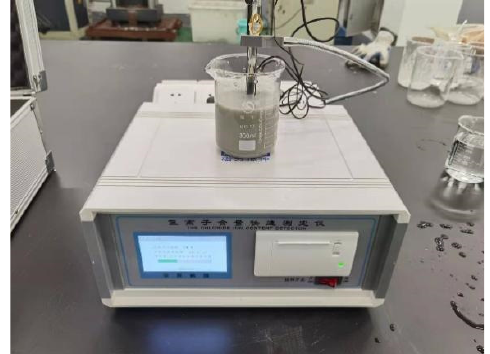
Figure 6. Chlorine ion fast tester.